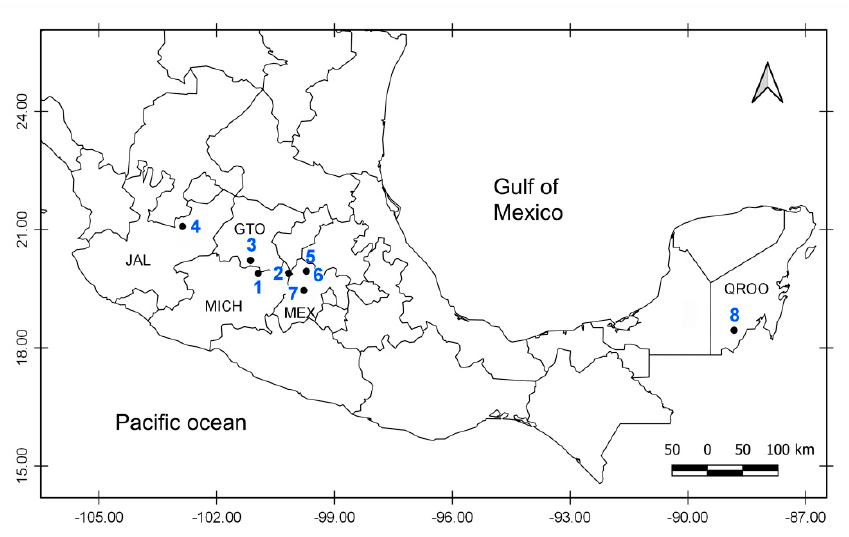
Figure 1. Sample locations of the Keratella taxa from Mexico. Numbers on the map correspond to the numbers in Table S1. Locations 1 to 5 were collected in this study. Samples for locations 6 to 8 were obtained from [6]. 1 = Cuitzeo lagoon, 2 = Santa Teresa dam, 3 = Yuriria dam, 4 = Tepatitlan-Yahualica pond, 5 = Huapango dam, 6 = Timilpan pond, 7 = Ignacio Ramirez dam, 8 = Aguada Kohunlich. JAL = Jalisco state, GTO = Guanajuato state, MICH = Michoacan state, MEX = Mexico state, QROO = Quintana Roo state.